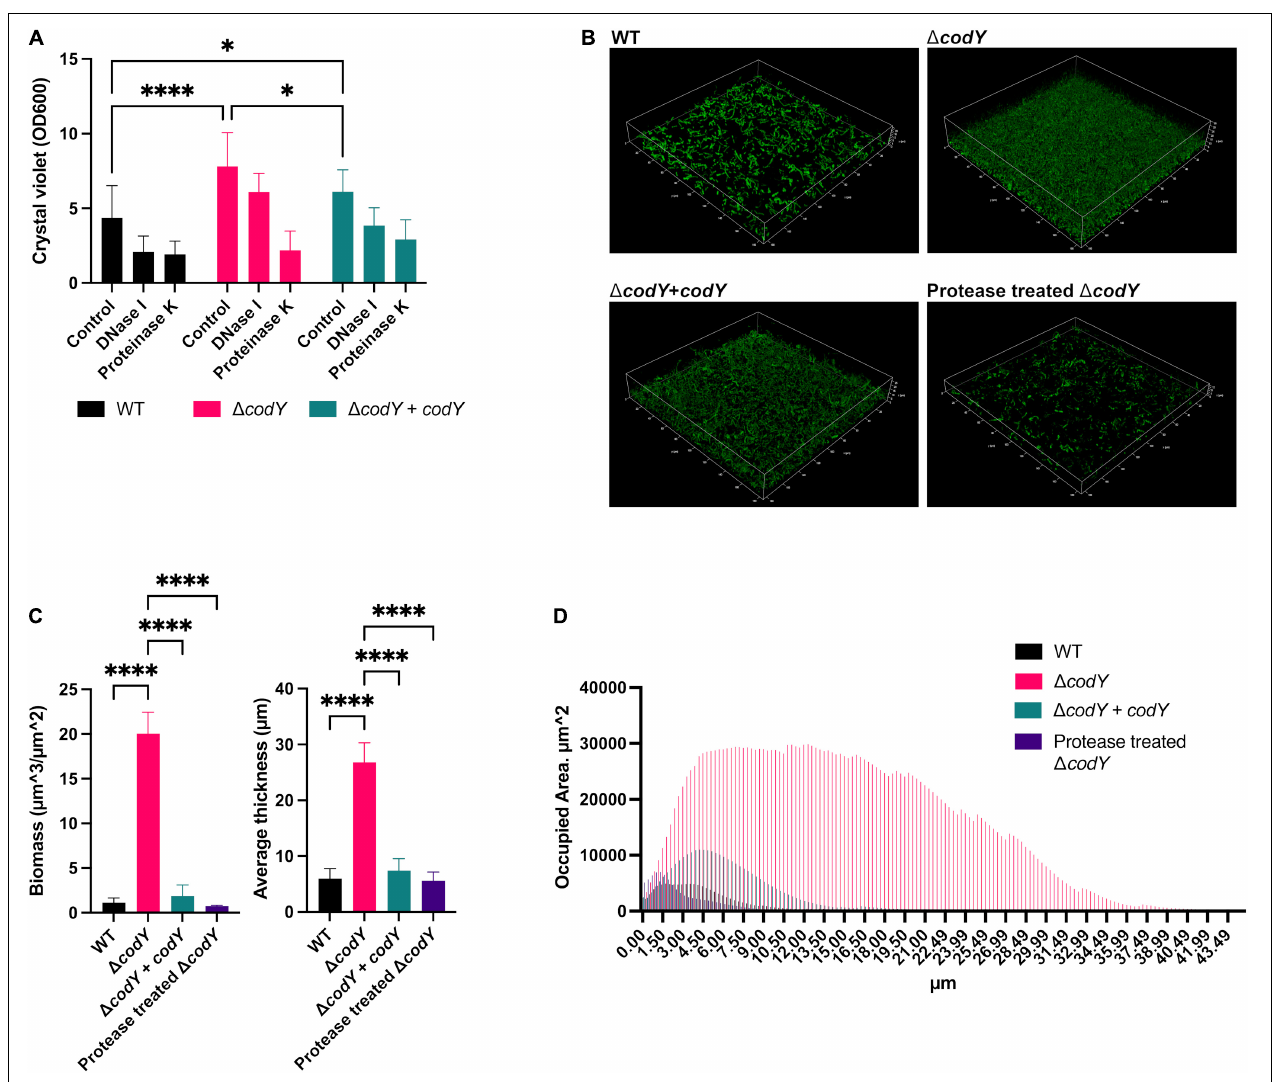
FIGURE 4 | CodY inhibits biofilm formation. (A) Biofilm biomass was measured by crystal violet staining after static culture for 19 h. The WT and the (cid:49) codY strain contain the empty vector pTCV (cid:127) P tet or the complementing vector pTCV (cid:127) P tet _ codY (+ codY ). The role of eDNA and extracellular proteins as biofilm structural components was assessed by individual treatments with DNase I and proteinase K, respectively. Represented data are the average ± SD of two independent experiments, each performed in 8 replicates. Statistically significant differences are reported (two-way ANOVA). (B) Confocal laser scanning microscopic images of biofilms formed by WT, (cid:49) codY and (cid:49) codY + codY GBS strains grown for 19 h in Nunc TM Lab-Tek TM II Chambered Coverglass. The effect of treatment with proteinase K on the (cid:49) codY biofilm is reported. (C,D) Analysis of biofilm properties by COMSTAT 2. Measures of total biomass, average thickness (C) and % of the area occupied by biofilm distribution (D) . Data are the average ± SD of the results from three independent replicates. : ∗ p < 0.05, ∗∗∗∗ p < 0.0001 (one-way ANOVA